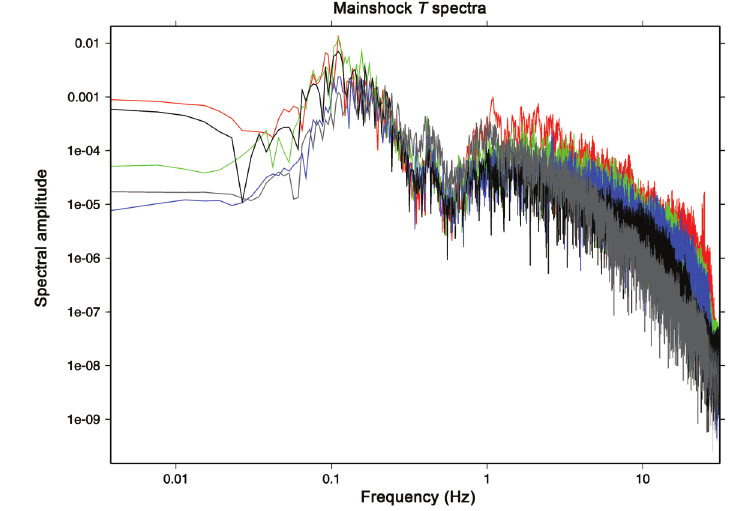
Fig. 7. Spectra of the presumed T phase for stations GENL (red line), NEGI (green line), RONM (blue line), MONE (black line) and ROTM (grey